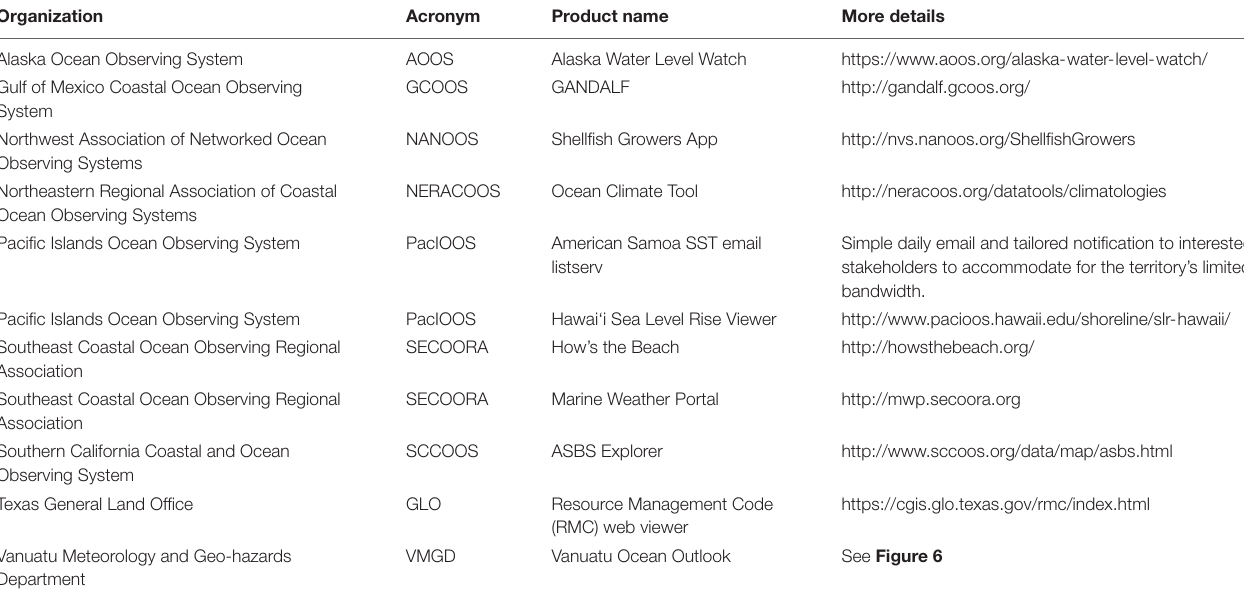
TABLE 1 | List of organizations and web addresses for the data products described within this